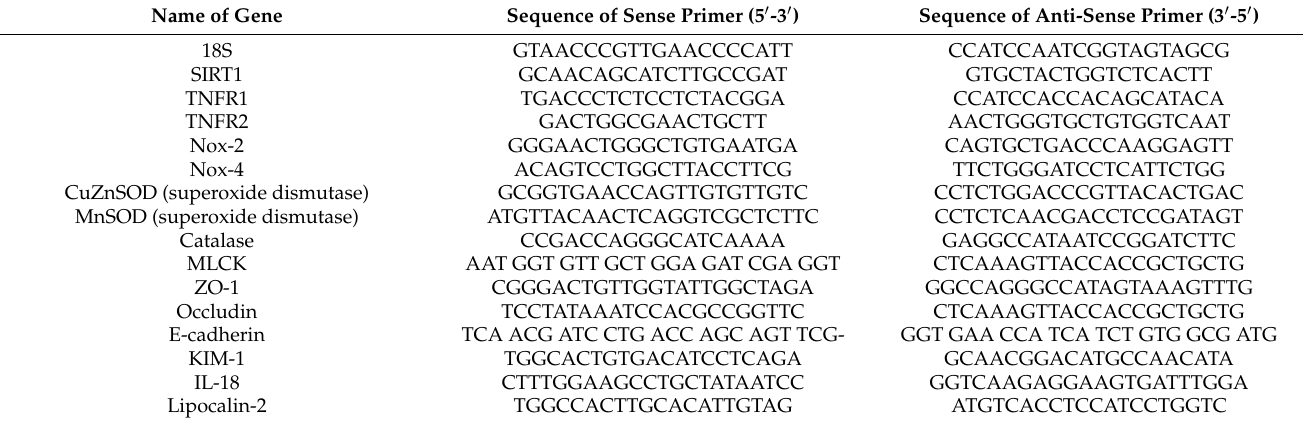
Table 2. Primer sequences used for various genes expression analysis by real-time